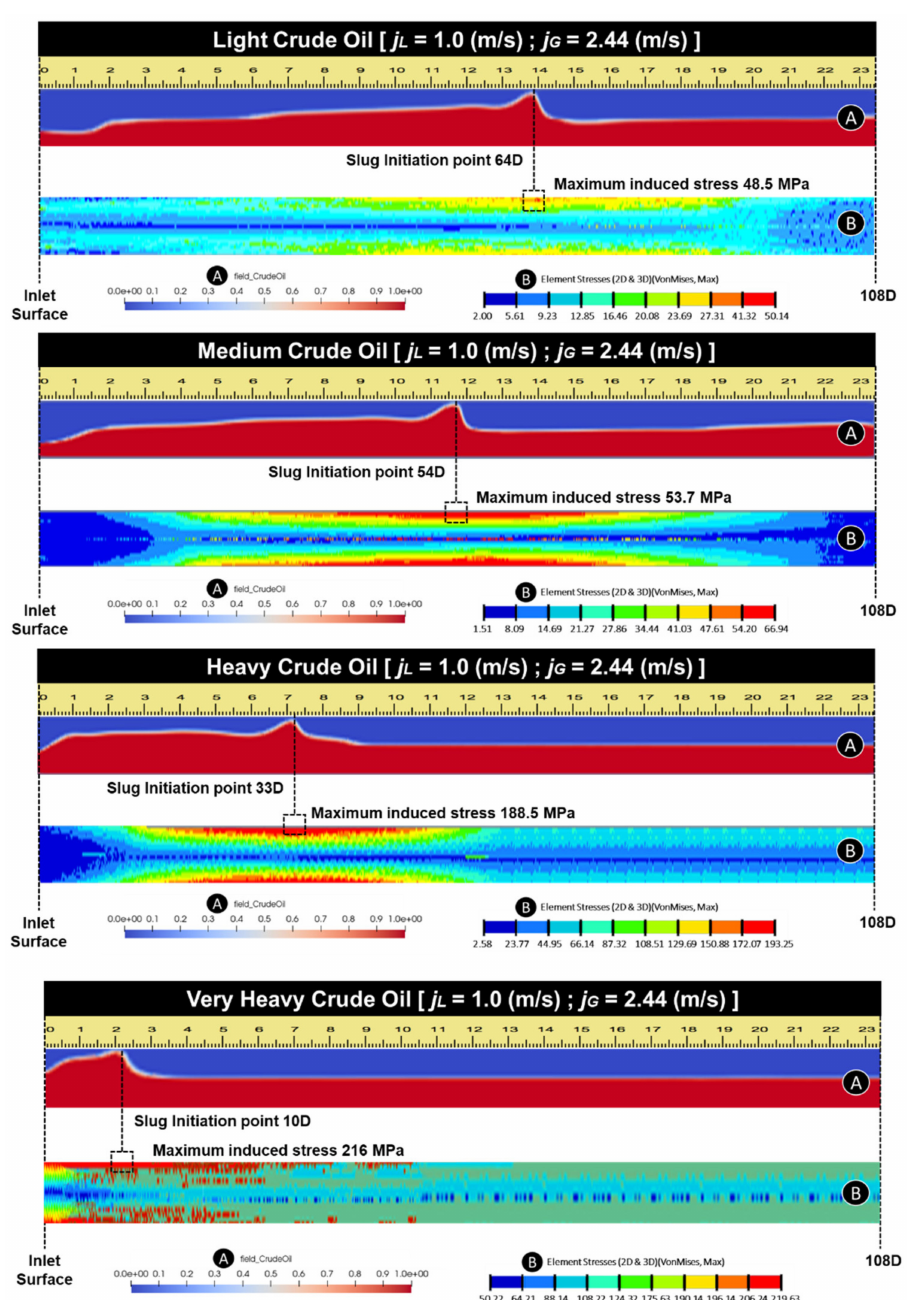
Figure 16. Effect of slug hydrodynamics (A) on the maximum induced stresses (B) (‘D’ represents pipe